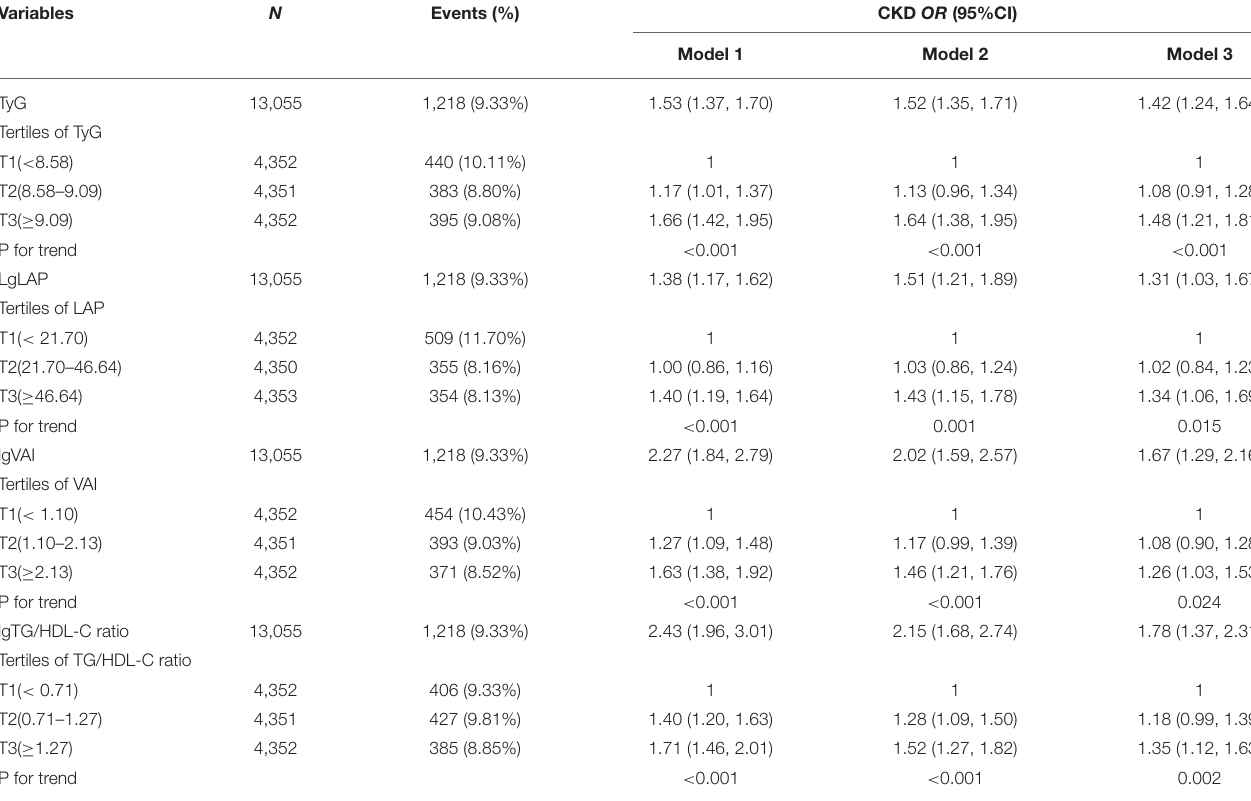
TABLE 2 | Odds ratio of CKD according to continuous or tertiles of surrogate markers of IR.